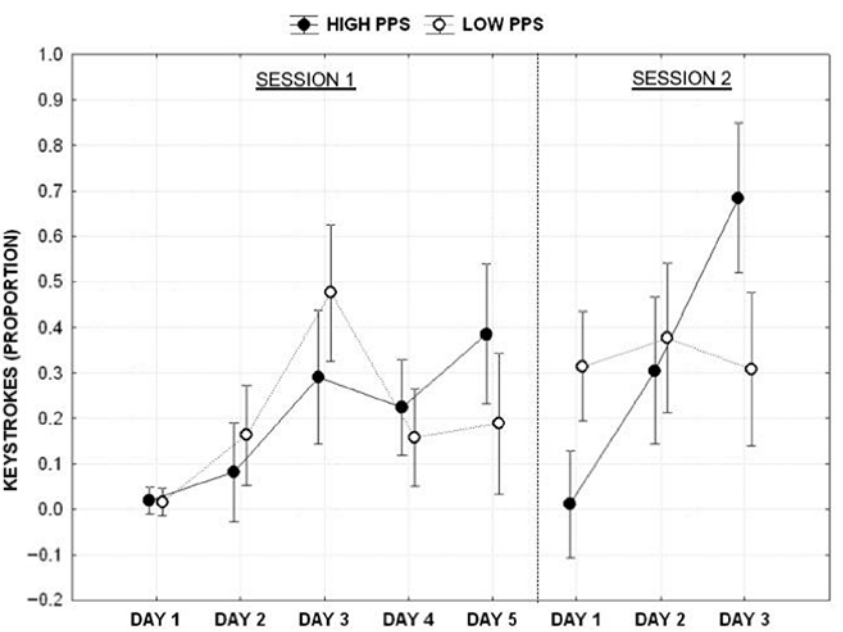
Figure 2. Proportion of keystrokes (text production) separately per session, day, and category of subjects. Vertical bars denote 0.95 confidence intervals.